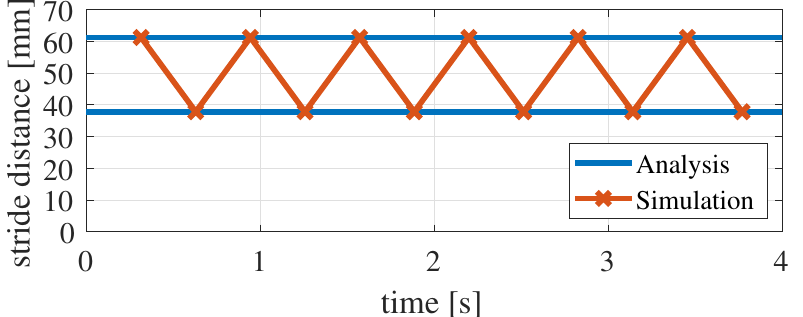
Figure 10. The time variation of the stride length in the simulation for the clockwise turning locomotion. The simulation results show that the robot walks with different stride lengths in each half period.